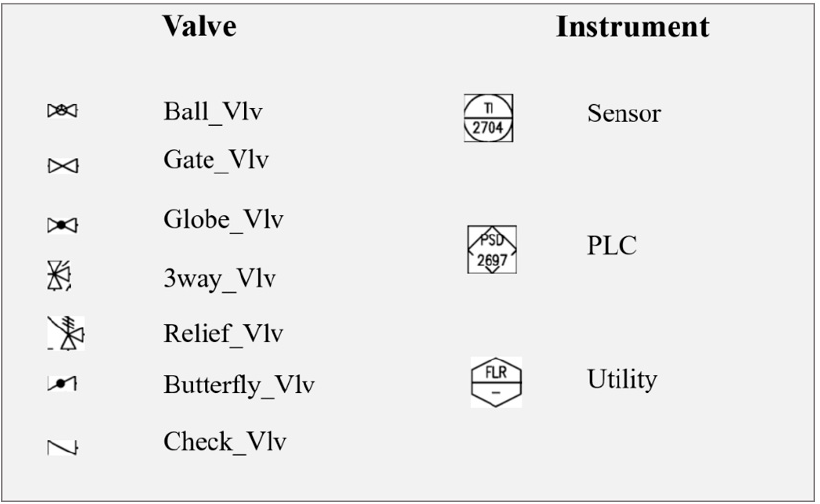
Figure 1. A framework summary for symbol recognition of the piping and instrument diagram (P&ID).